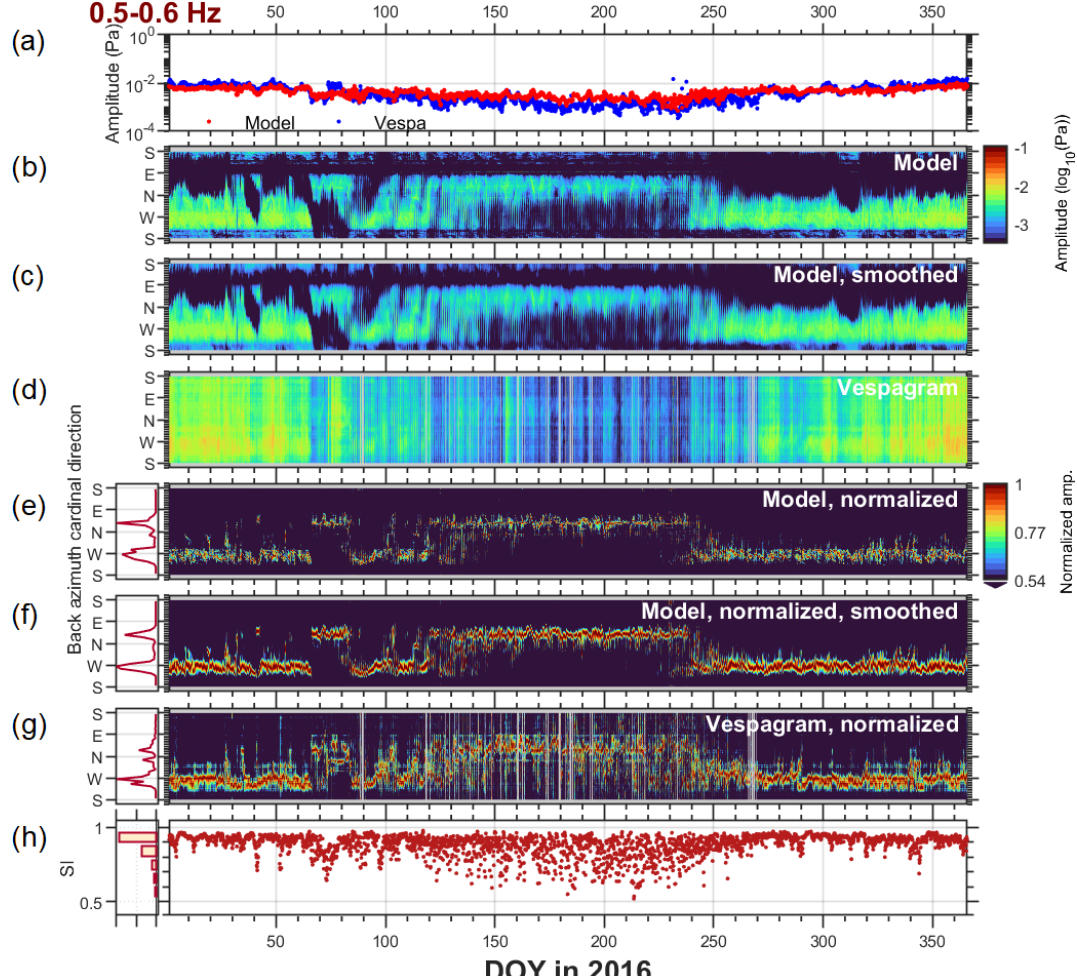
Figure 4. Same as Fig. 3 but for